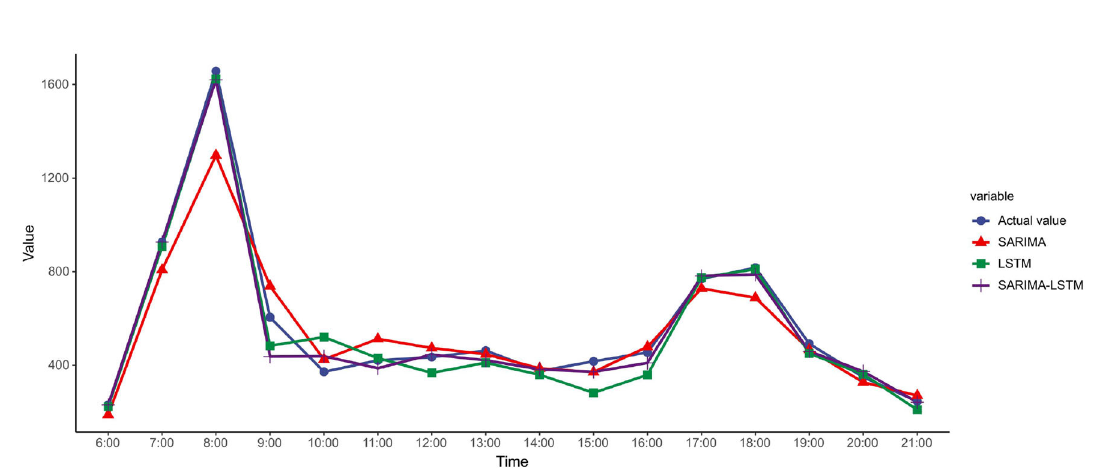
Fig. 5 Comparison of prediction results of different